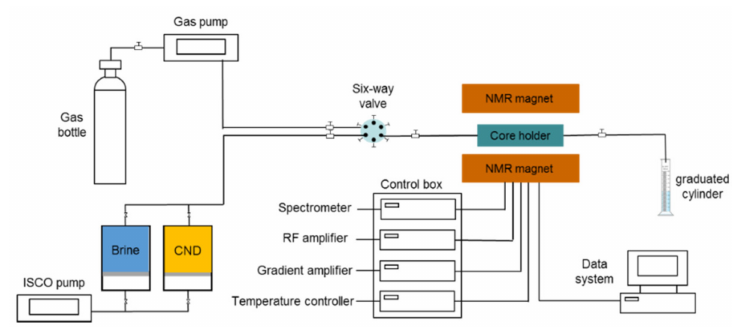
Figure 6. Schematic diagram of the NMR experimental